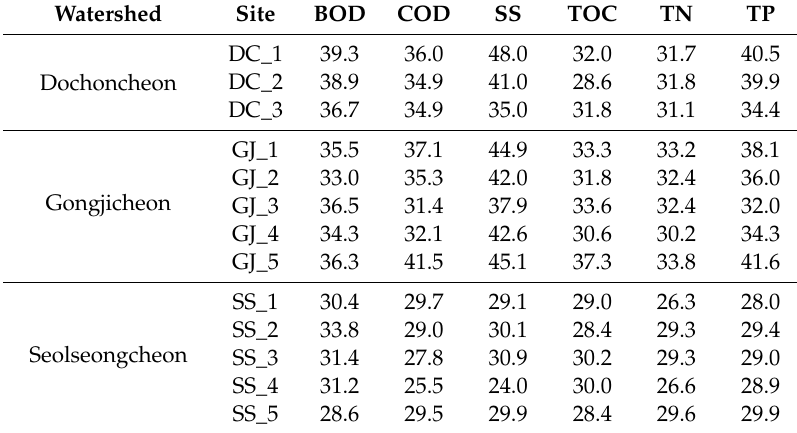
Figure 6. First flush effect during rainfall at three watersheds (red: Dochoncheon, black: Gongjicheon, blue: Seolseongcheon). Table 4. Average cumulative load (%) relative to 30% of cumulative runo ff flow at each